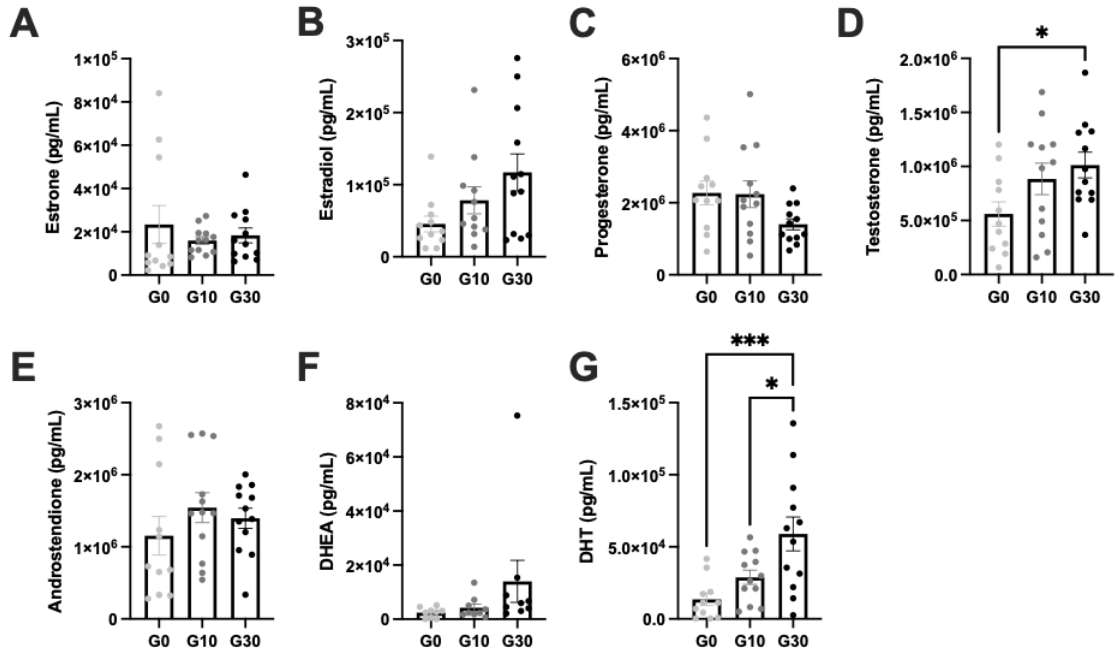
Figure 3. Cumulative hormones production reveals excess testosterone and DHT production in G30 group. Cumulative production of each steroid hormone was calculated by taking the sum of hormone productions from samples collected on alternate days from culture day 2–culture day 27. Cumulative production for ( A ) estrone, ( B ) estradiol, ( C ) progesterone, ( D ) testosterone, ( E ) androstenedione, ( F ) DHEA (dehydroepiandrosterone) and ( G ) DHT (dihydrotestosterone). Data are presented as the mean ± SEM. n = 11–12 samples/group. Statistical significance determined with one-way ANOVA with Tukey’s multiple comparison test and/or post hoc test for linear trend (results of the latter test cannot be illustrated on the graphs above, but corresponding p values are included in the text of the Results section). * signifies p < 0.05, and *** signifies p < 0.001. G0 = standard media (no hCG), G10 = physiologic ratio media (1:1 hCG:FSH), G30 = PCOS-like ratio (3:1 hCG:FSH). Abbreviations: hCG = human chorionic gonadotropin, FSH = follicle stimulating hormone.